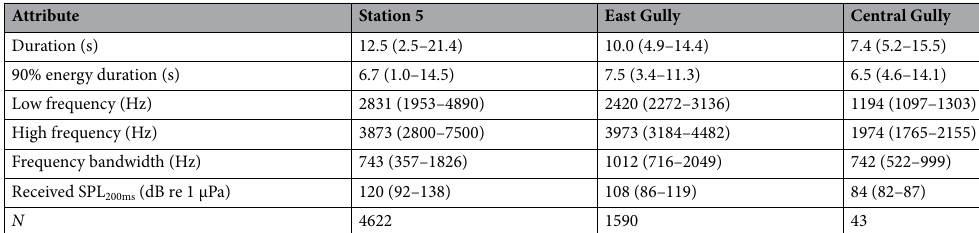
Attribute Station